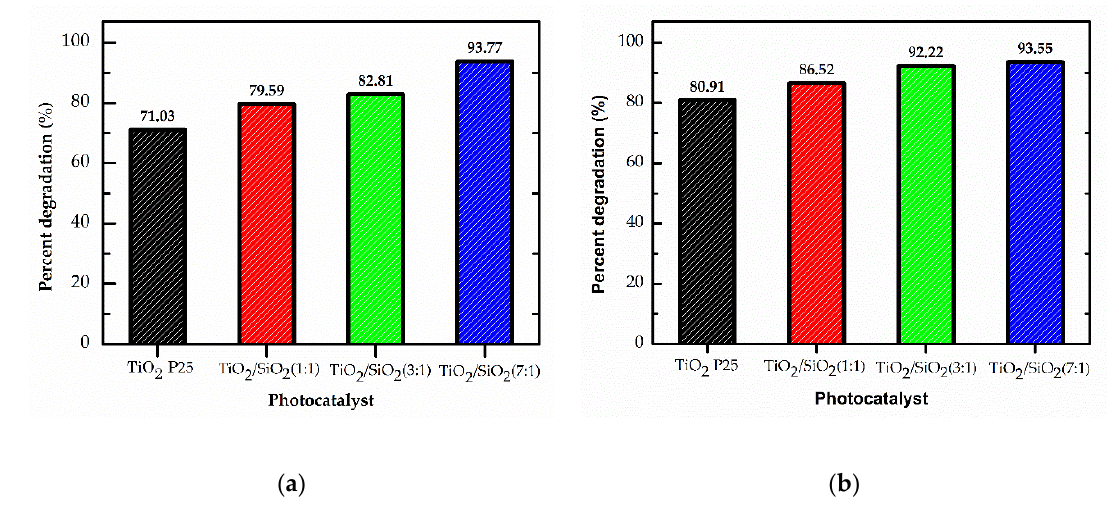
Figure 7. ( a ) Efficiency of decreasing Cr(VI) concentrations and; ( b ) Pb(II) concentrations after ultraviolet (UV) irradiation for 180 min. The experiment was conducted using 100 mg